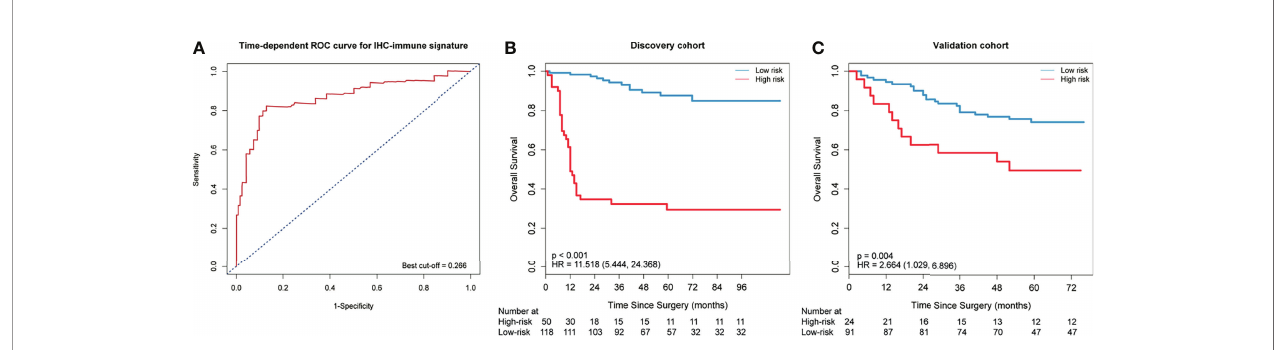
FIGURE 3 | Time-dependent receiver-operating characteristic (ROC) curve and Kaplan – Meier survival curves. (A) Time-dependent ROC curve at 3 years in the discovery cohort. Patients were strati fi ed into high- or low-risk group based on the cutoff value (cutoff=0.266). Kaplan – Meier survival curves for overall survival (OS) in the discovery (B) and validation cohort (C) according to the immunohistochemistry (IHC)-immune signature.